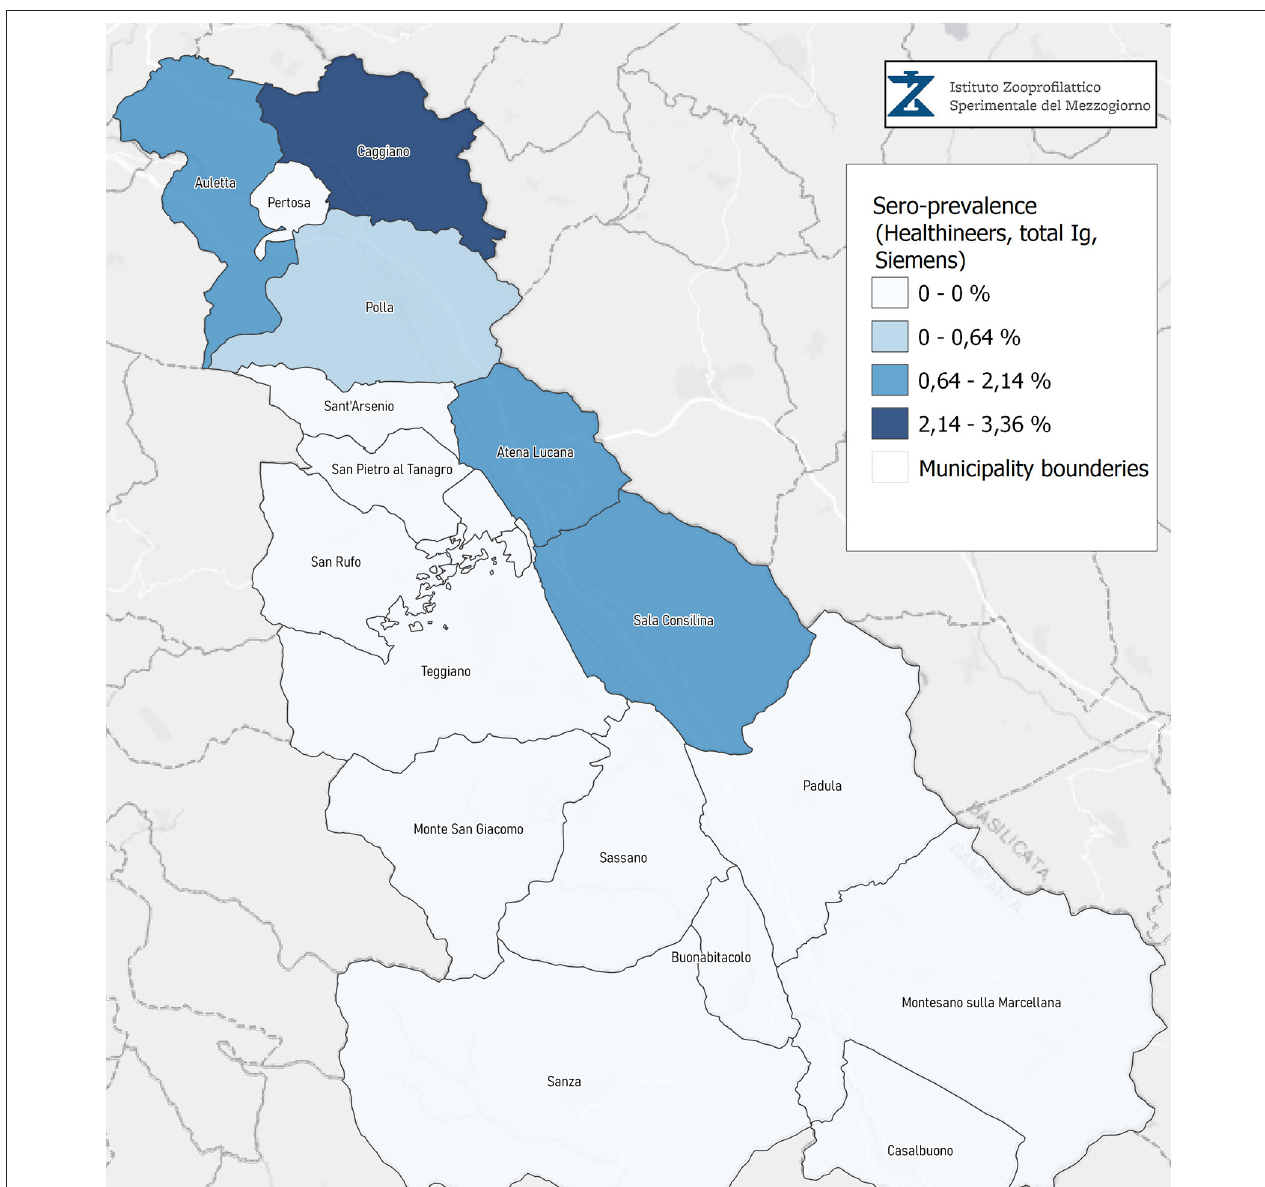
FIGURE 4 | Seroprevalence assessed in Diano Valley municipalities by Healthineers, total Ig